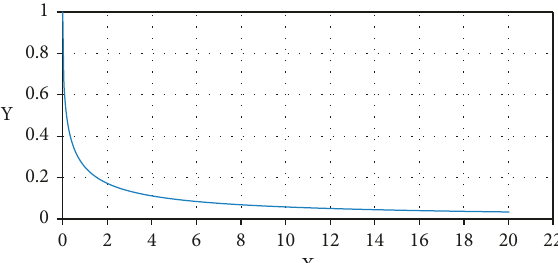
Figure 3: The graphical illustration of equation